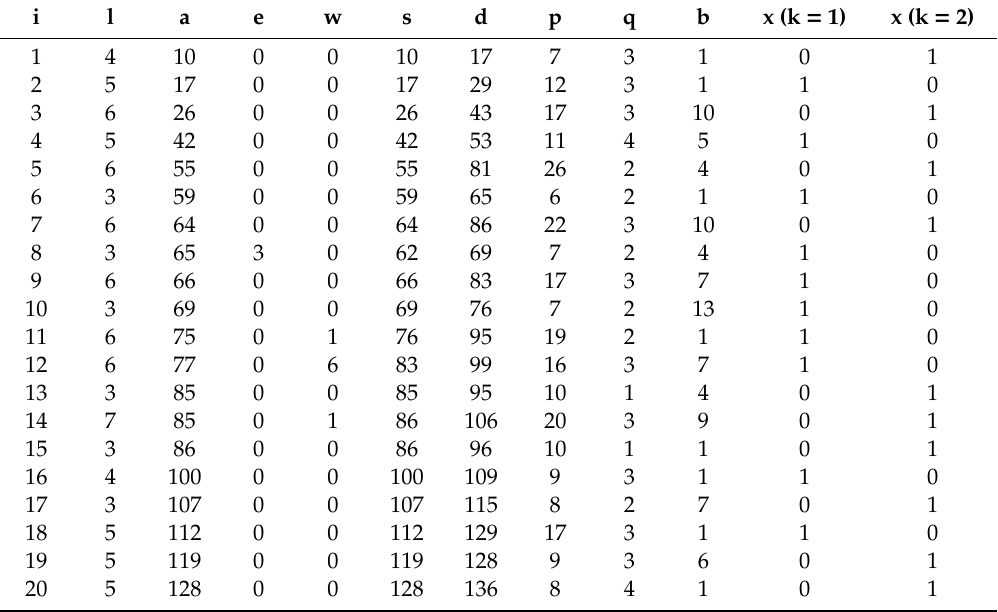
Table A8. Results of the integrated BAP and QCAP solution for Case 20: seed = 700, λ = 3.5, Z (cid:48) =